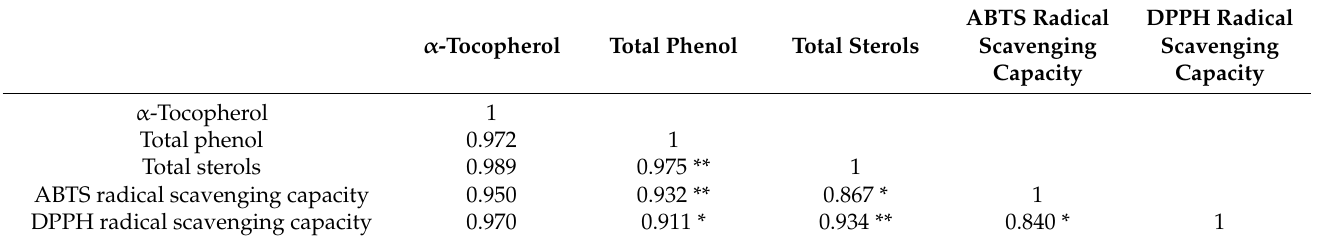
Table 8. Correlation analysis between lipid concomitant compounds and antioxidant capacity in vitro.